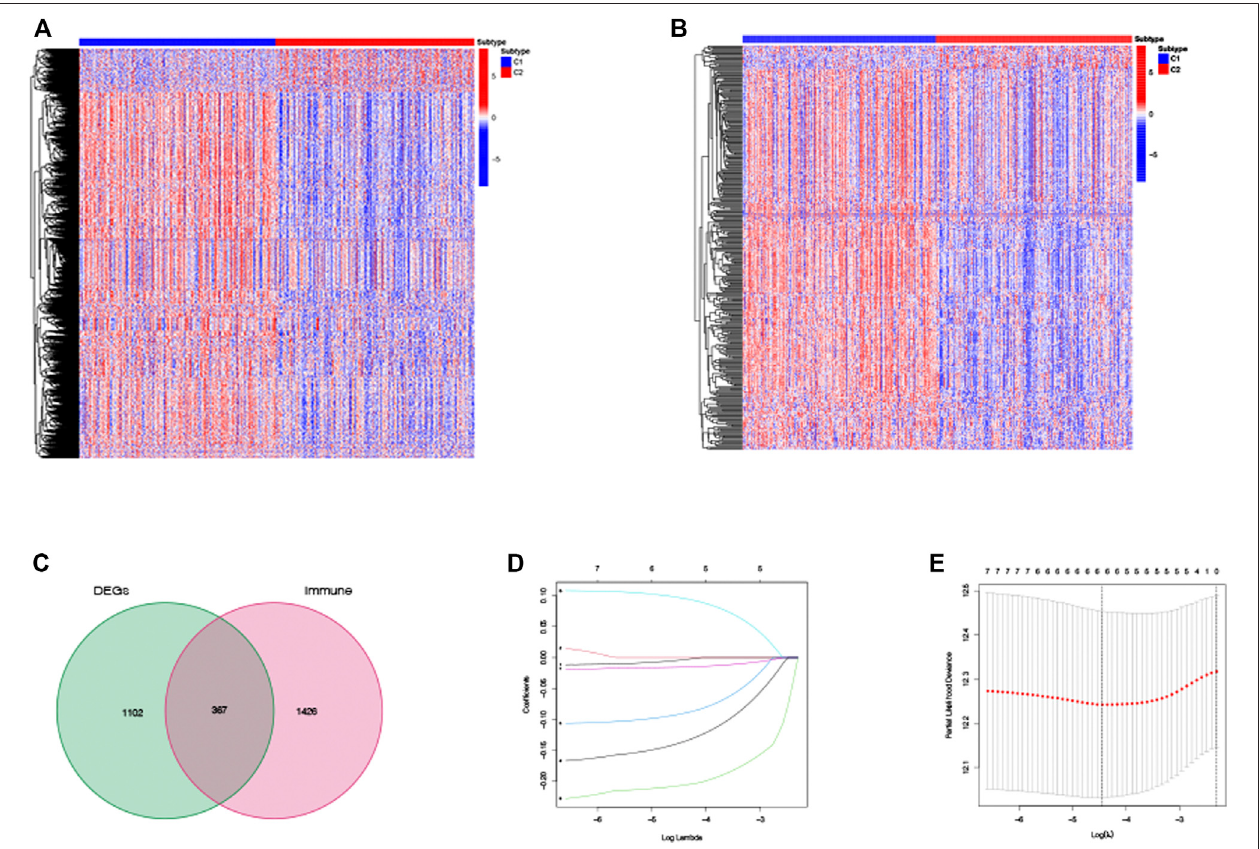
FIGURE 4 | DEG and DEIG expressions and establishment of the prognostic TRIG score in the TCGA cohort. (A,B) . Heatmaps of DEGs and DEIGs between two subtypes. (C) . TRIGs between two subtypes. (D) . LASSO regression of the six TRIGs. (E) . Cross-validation of parameter selection of the LASSO regression.